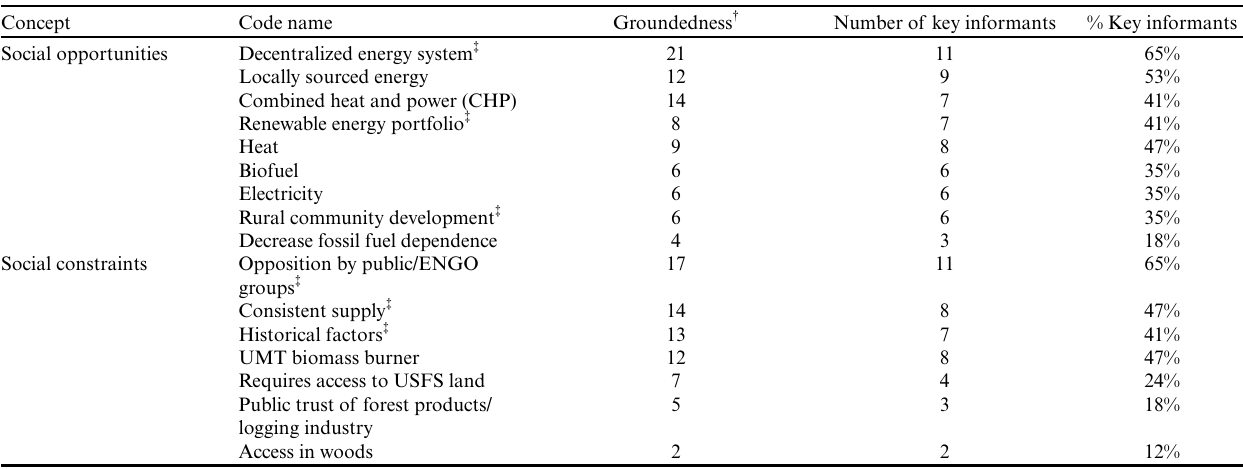
Table 3 . Social opportunities and constraints of wood-based bioenergy (WBB) in western Montana. For each root code and subcode, we include the number of times the code was referred to in the interviews (groundedness), the number of key informants that discussed the code, and the percentage of key informants that described the